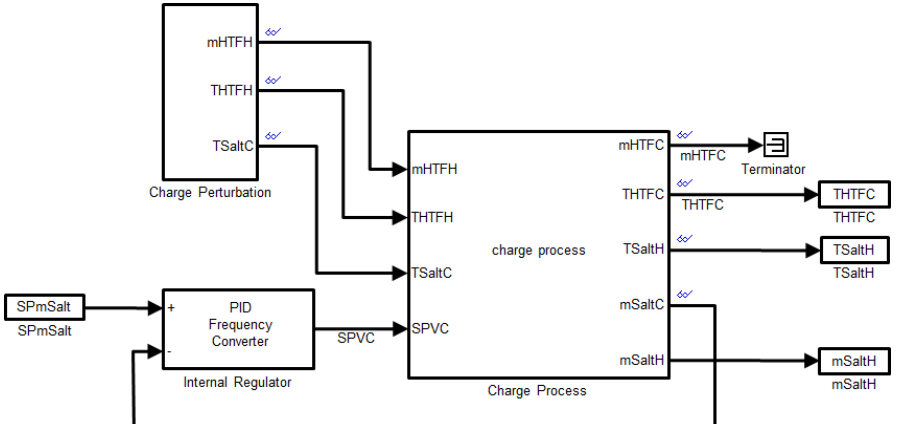
Figure 6. Simulink model for TES charge simulations.